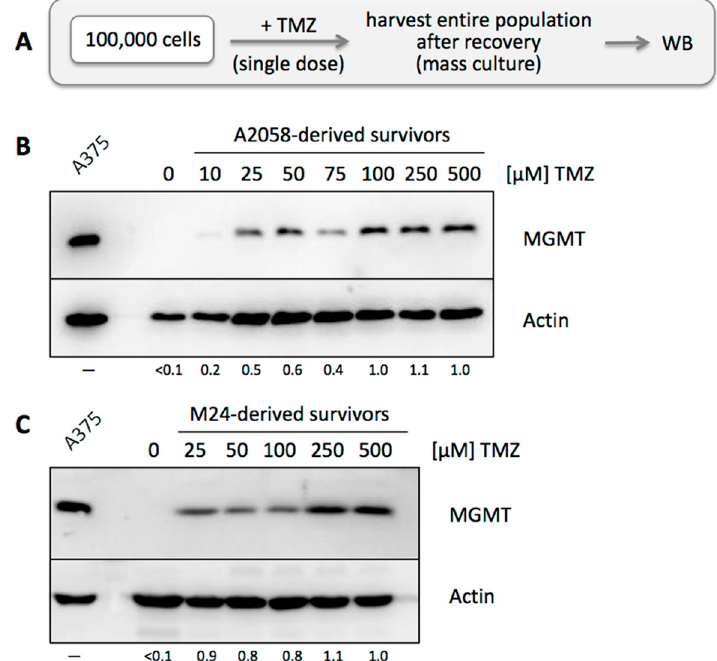
Figure 4. MGMT protein levels in mass cultures after TMZ treatment. ( A ) Treatment schedule was as follows: 10 5 cells were seeded into the wells of a 6-well dish and treated with a single dose of TMZ at increasing concentrations from 0 to 500 µ M for 48 h. Surviving cells were kept in culture until the population had regrown sufficiently to harvest enough cells for WB analysis. ( B ) Cell lysates were prepared from mass cultures of surviving A2058 cells and analyzed by WB for MGMT protein levels. Actin was used as a loading control. A lysate of A375 cells was used as a positive control for MGMT protein. ( C ) The same experiment was also performed with M24 cells. Please note that MGMT protein was undetectable before TMZ treatment in both cell lines. Numbers under the blots indicate quantification of MGMT bands, with reference to the actin signal, and relative to the highest TMZ concentration used (right lane, set at 1.0); <0.1 indicates below detection limit.